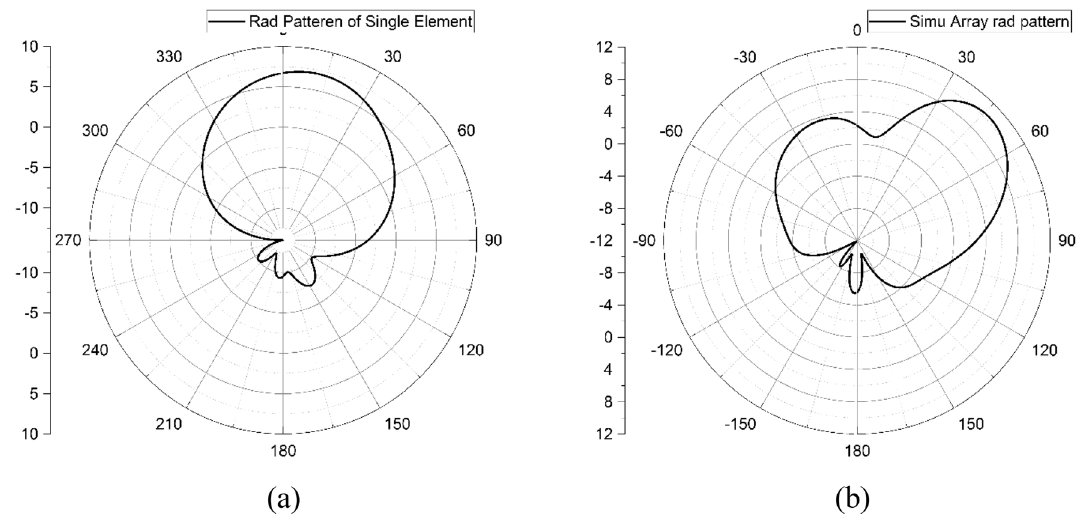
Figure 5. XZ plane (H-Plane) simulated radiation pattern of single element and antenna array.